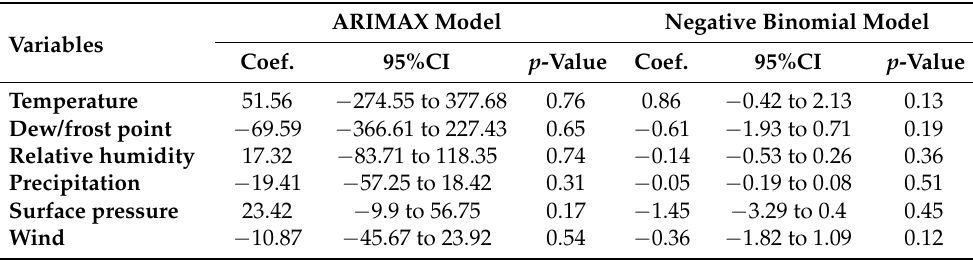
Figure 4. Time series plot of confirmed cases for different methods: ( a ) Simple Exponential Smoothing (SES), ( b ) Auto-Regressive Integrated Moving Average (ARIMA), ( c ) Autoregressive Integrated Moving Average with Explanatory Variable (ARIMAX), and ( d ) Automatic Forecasting time-series model (Prophet Model). Table 3. Meteorological factors associated with monkeypox cases using ARIMAX and NB